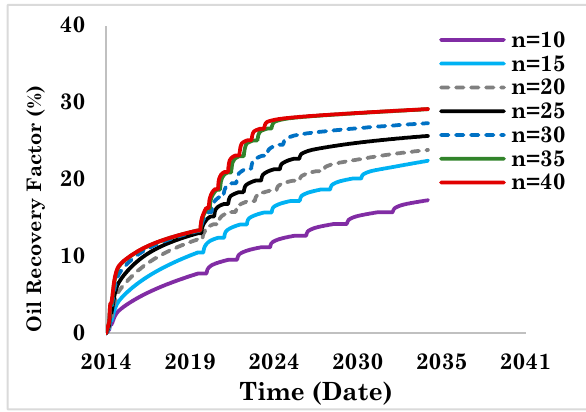
Figure 12. CO 2 Injection (Fixed Cycle Size) 38 API Oil.